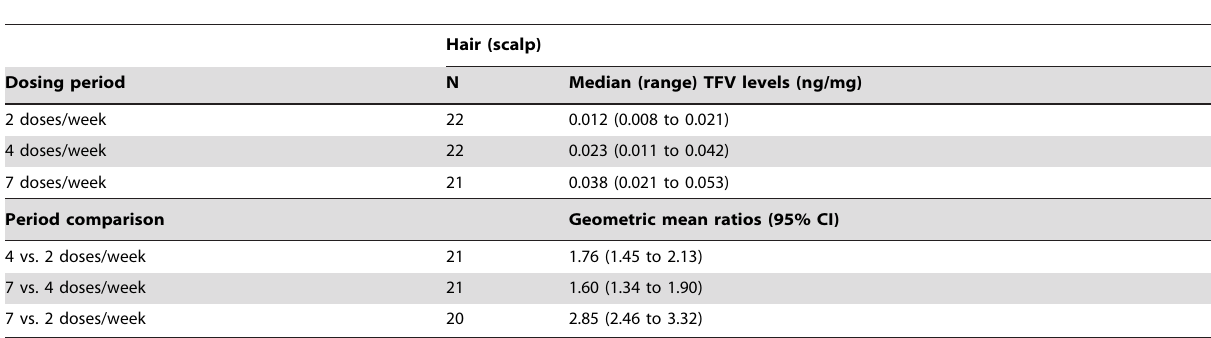
Table 2. Median drug levels and geometric mean ratios in hair after 6 weeks of use, by dosing period.